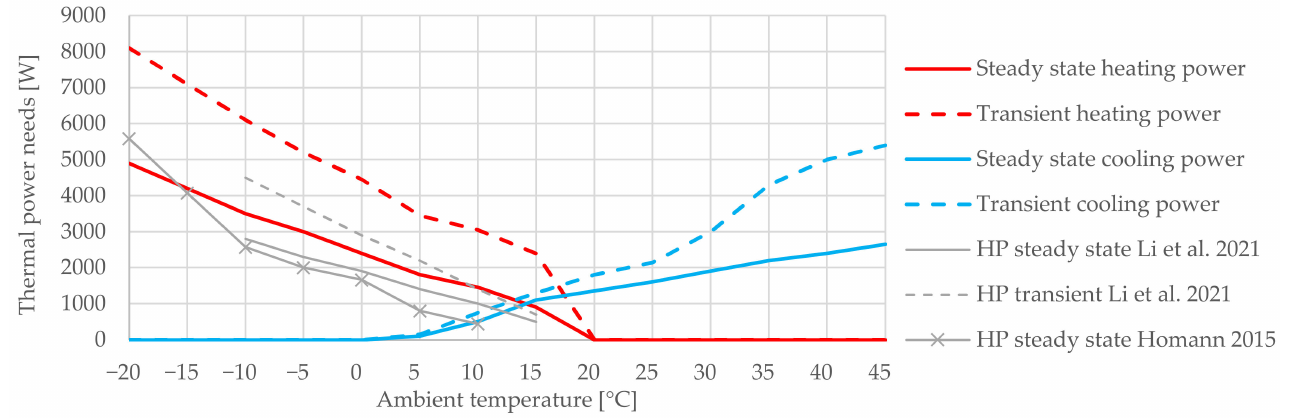
Figure 3. Heating power needs are shown in red lines and cooling power needs in blue lines for a mid-sized passenger car based on a cabin thermal model developed by Mansour et al. [19] in comparison to other studies that featured battery electric vehicles with heat pumps (HP) from Li et al. [18] and Homann